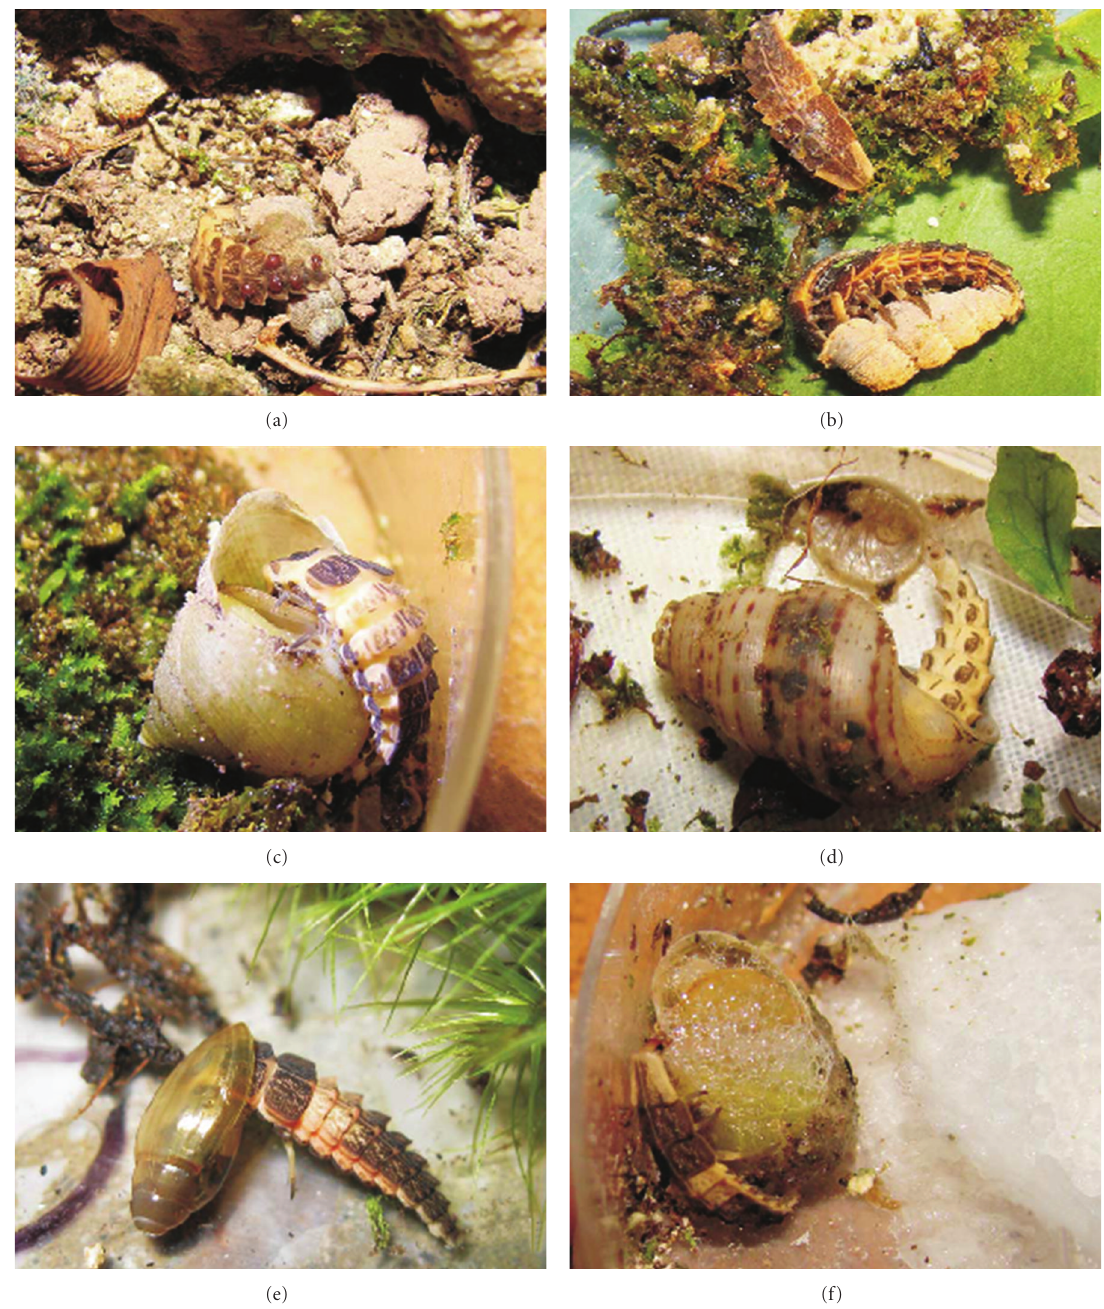
Figure 2: Larval feeding habits of Alecton discoidalis . (a): Larva feeding on Torrella inmersa in nature. (b): Two larvae of early stages feeding on Torrella inmersa in captivity. (c): Predation on Ustronia sloanei , keeping the operculum at side in captivity. (d): Predation on Chondropoma pictum , with the operculum out, in captivity. (e): Predation on the carnivorous snail Oleacina sp. in captivity. (f): Foamming behaviour of Helicina aspersa while